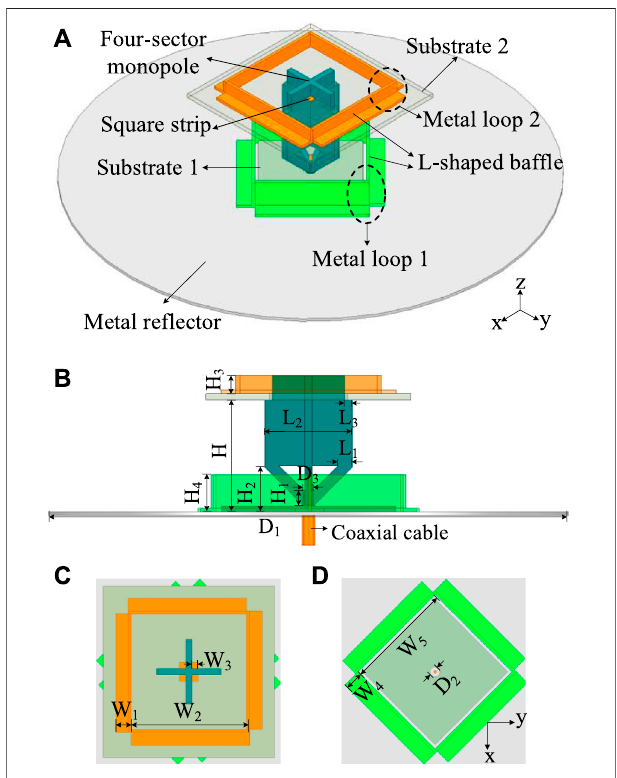
FIGURE 1 | Geometry of the proposed antenna: (A) perspective view, (B) side view, (C) top view, and (D) metal loop 1.